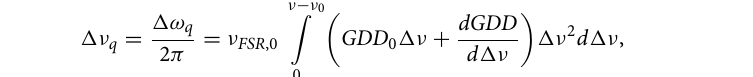
profile line shape parameters for the individual methane lines in HITRAN2016 31 . The fitted parameters are: a —amplitude of the spectrum, ν l —position of the spectrum on the local frequency axis, Ŵ 0 —mode width cor- responding to the broadband cavity losses, δν 0 —constant detuning of the probe comb from the cavity modes, d ν FSR —mean difference between 4 × ν FSR and the probe comb f r . The amplitude a and position ν l were fitted as shared parameters between absorption and dispersion.